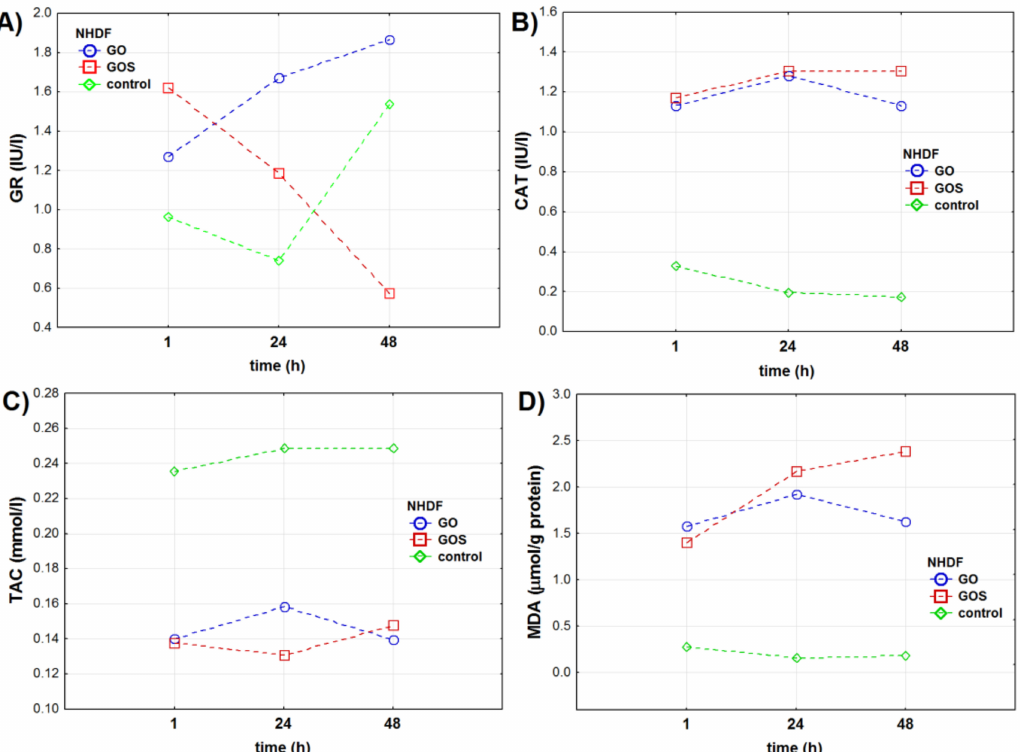
Figure 1. Oxidative stress markers in the NHDF (normal human dermal fibroblasts) cell line measured 1, 24, and 48 h after exposure to ultrapure (GO) or manganese ions-contaminated graphene oxide (GOS): ( A ) glutathione reductase (GR) activity (IU/L), ( B ) catalase (CAT) activity (IU/L), ( C ) total antioxidant capacity (TAC) (mmol/L), ( D ) malondialdehyde (MDA) concentration ( µ mol/g protein). The markers present mean value of the analyzed